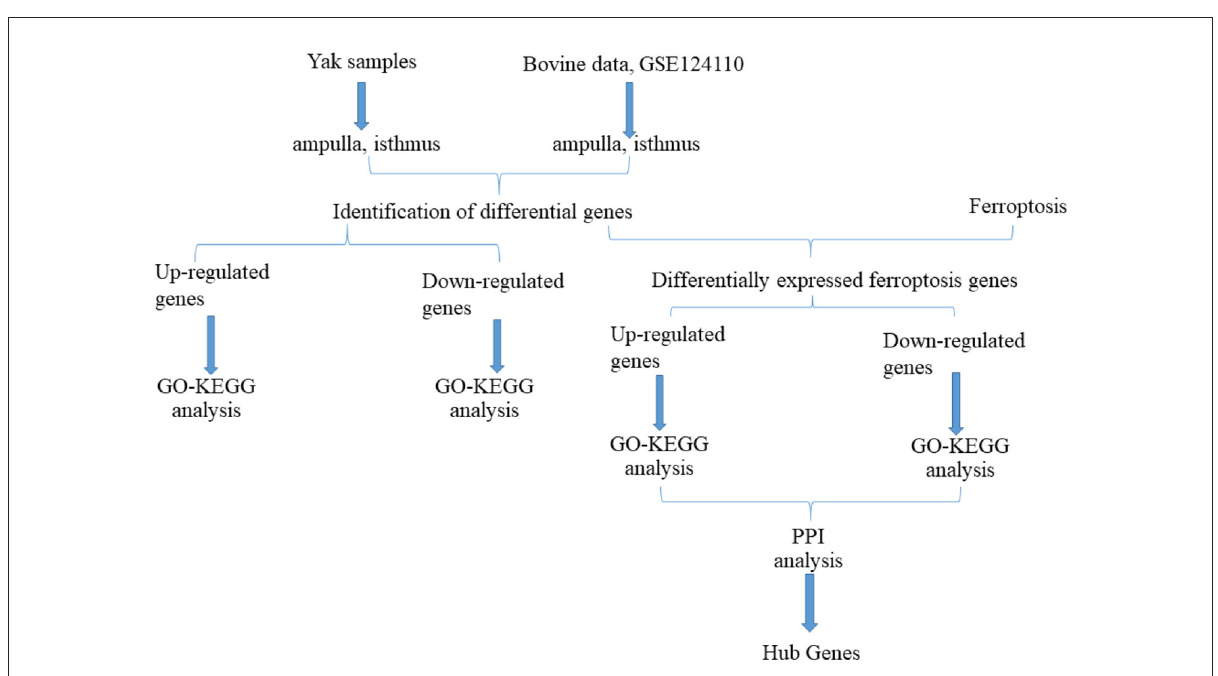
FIGURE1 Flow chart of this